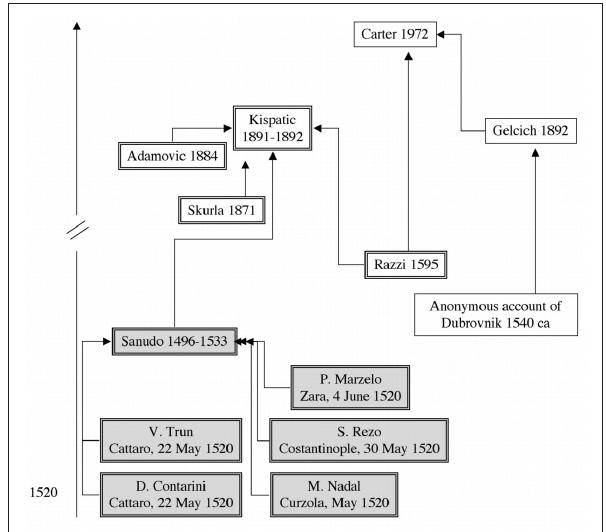
Fig. 7. Relationships between seismological and historical compilations and coeval sources on the earthquake of 17 May